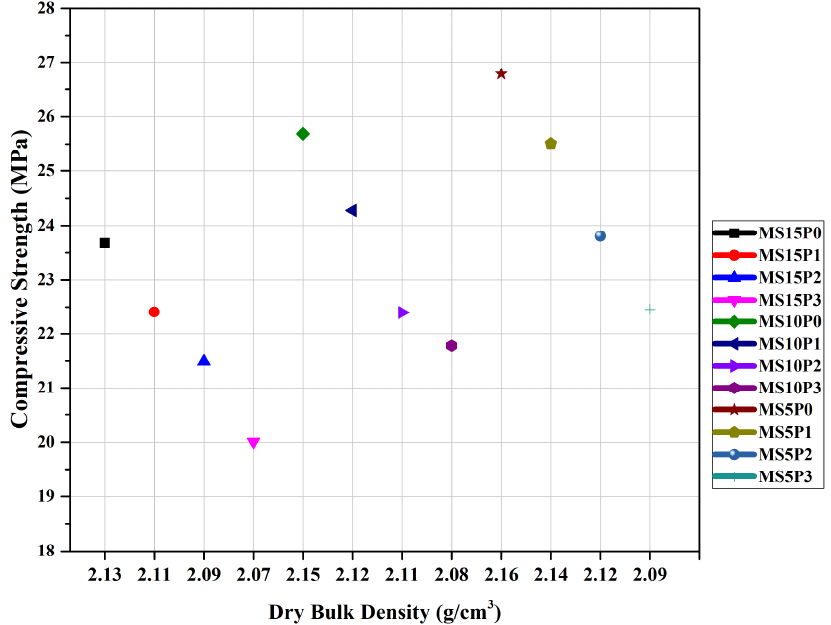
Figure 18. Relationship between compressive strength and dry bulk density of the MS samples.